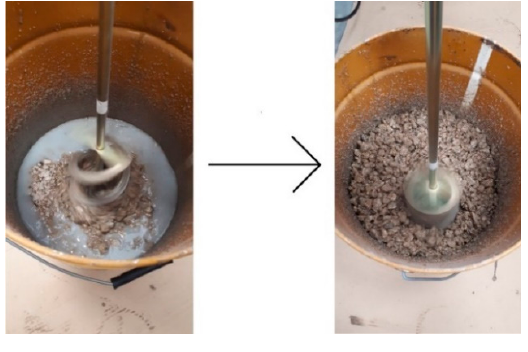
Figure 2. Matrix and fillers.